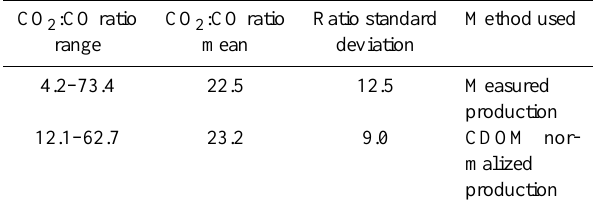
Table 2. CO 2 :CO mean production